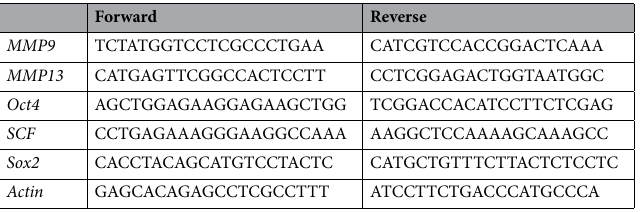
Table 1. qPCR primers. Primer sequences for genes examined by quantitative